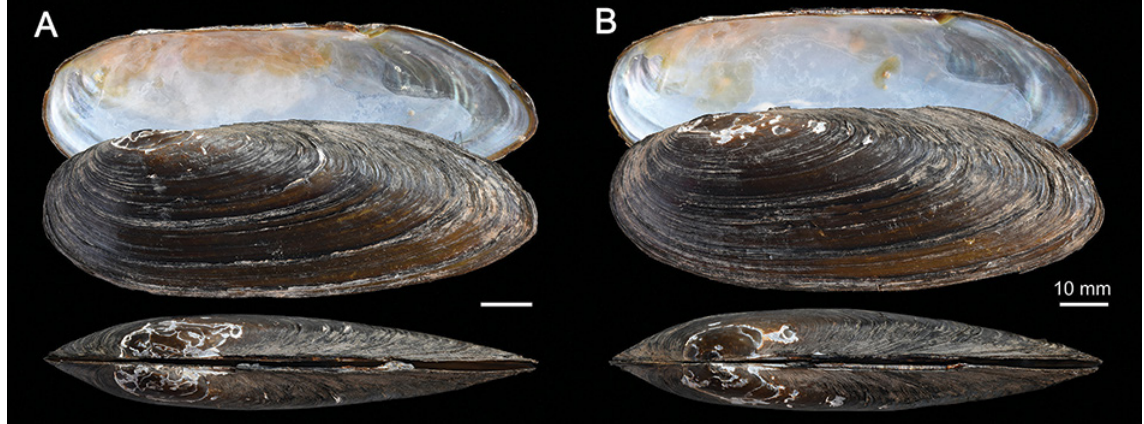
Fig. 4. Namkongnaia inkhavilayi gen. et sp. nov. A . Holotype MUMNH-UNI2831. B . Paratype MUMNH-UNI2836, both from the type localty in Xe Bangfai River, Kammoune Province, Laos. Scale bars: 10